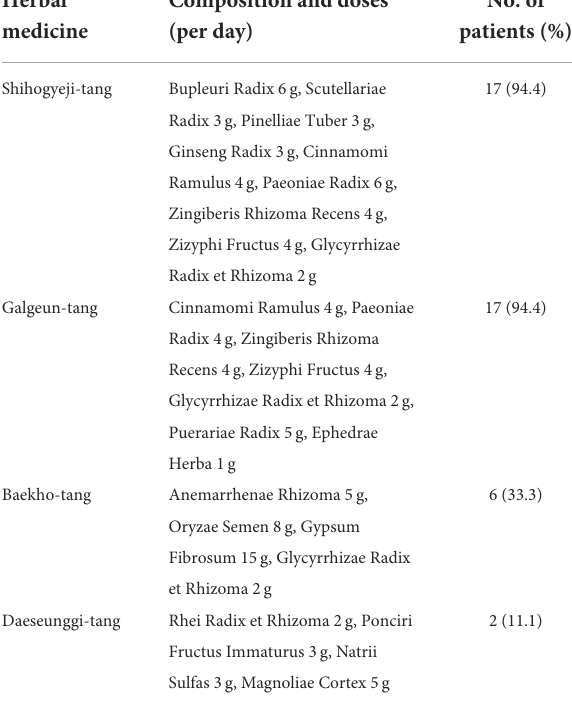
TABLE 1 Details of herbal medicine used. TABLE 2 Baseline demographic and clinical characteristics of patients.